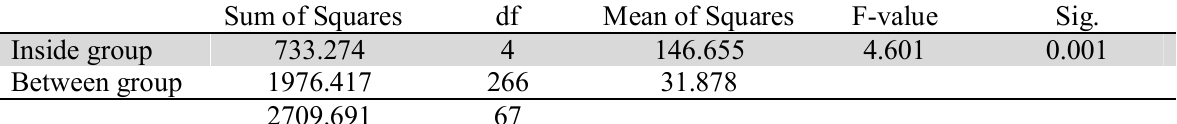
The results of testing the effect of income on product involvement in using mobile devices Sum of Squares Inside